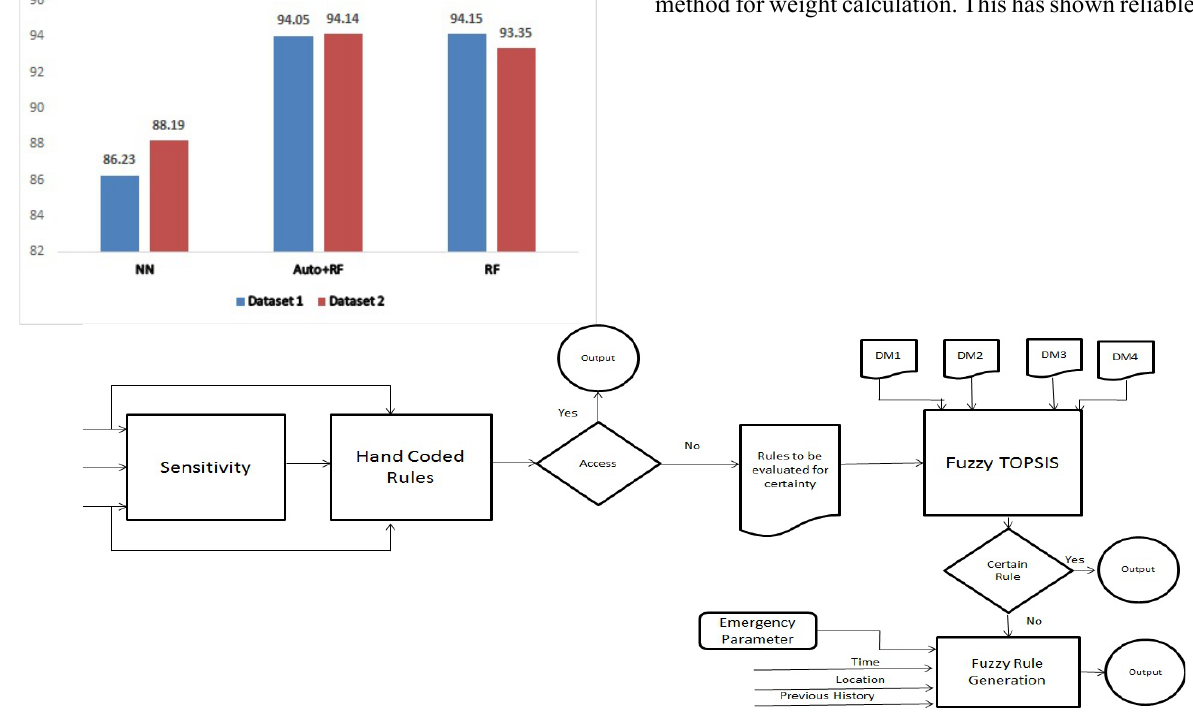
Figure 3. Comparison of Neural Network, Auto encoder with Random forest for classification